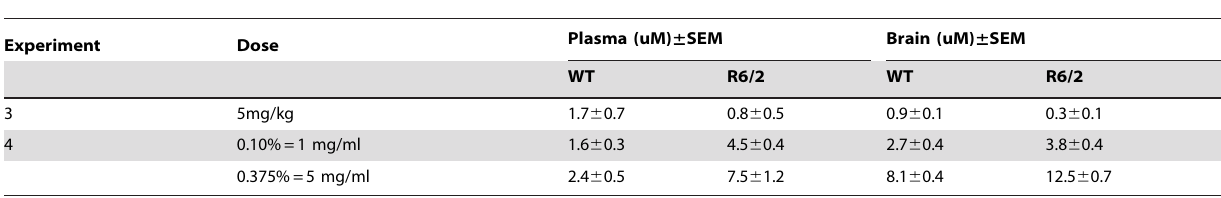
Table 2. Mean plasma and brain levels of